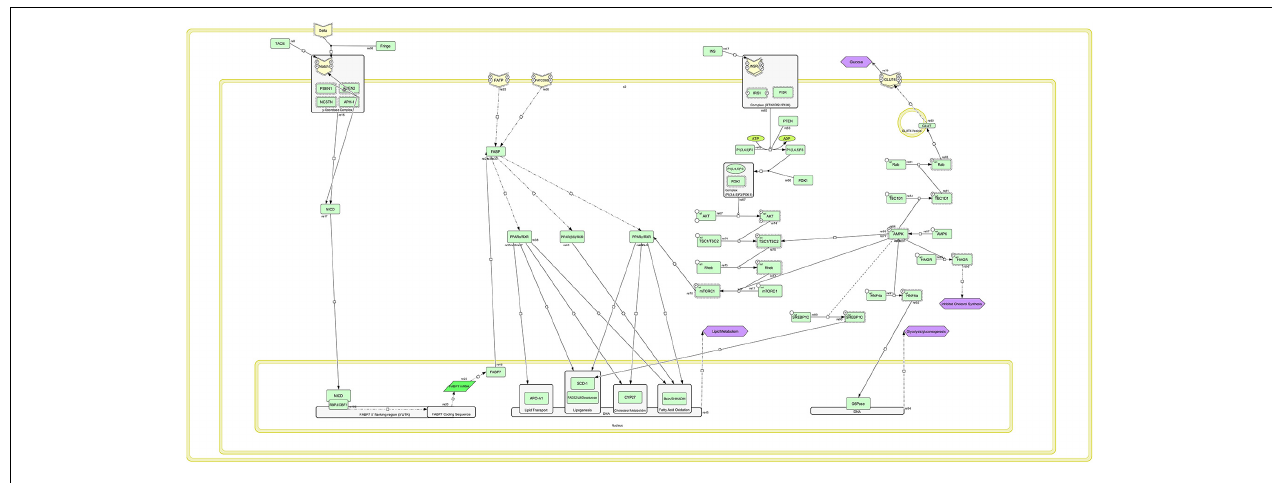
FIGURE 7 | Schematic of the regenerated metabolic-signaling network associated with fat metabolism and storage using